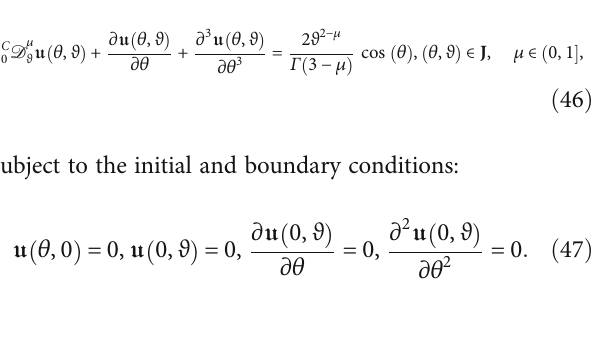
= k = 1, M = M = 6, and μ = 0 : 3, 0 : 5, 0 : 7, 0 : 9, 1 at time ϑ = 0 : 45 for Example 2. 1 2 1 2 = k = 1, M = M = 6 at equally spaced points for Example 1 2 1 2